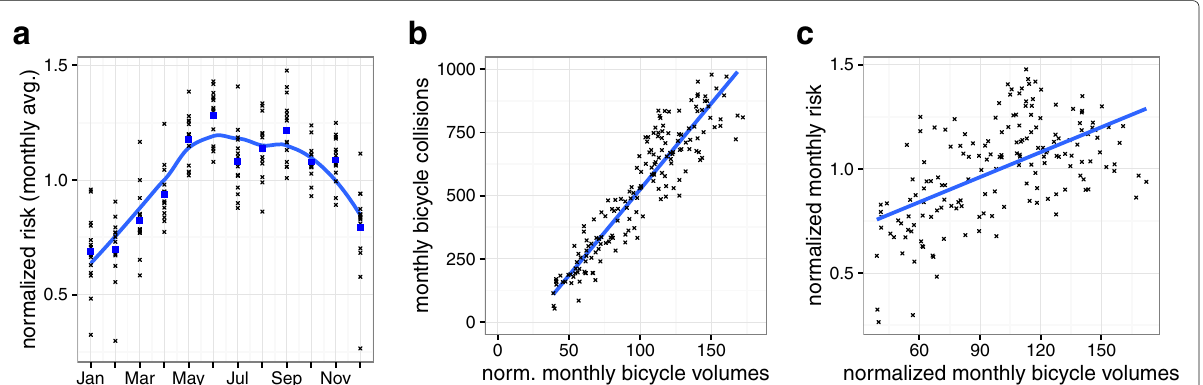
Fig. 6 a The normalized estimated risks (black crosses) per month. The total 14-year average per month is indicated by blue squares. b Linear fit (with intercept) to a negative binomial regression of the bicycle collision numbers by the normalized estimated monthly bicycle volumes. c Normalized estimated monthly risks with least squares fit for the same predictor as in ( b